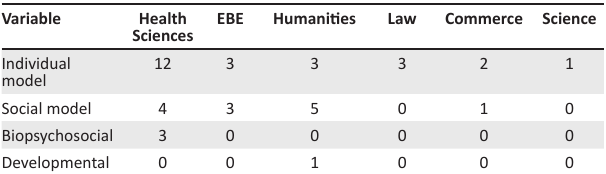
TABLE 1: Motivation for disability inclusion. TABLE 2: Understanding of